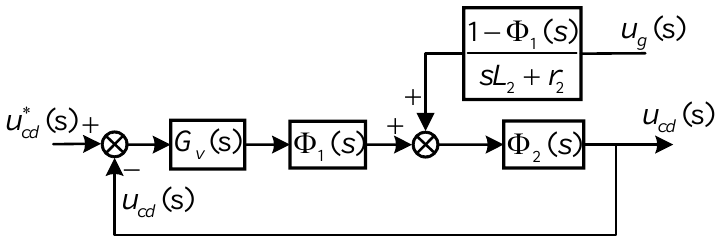
Figure 3. Control block diagram of voltage loop after transformation.